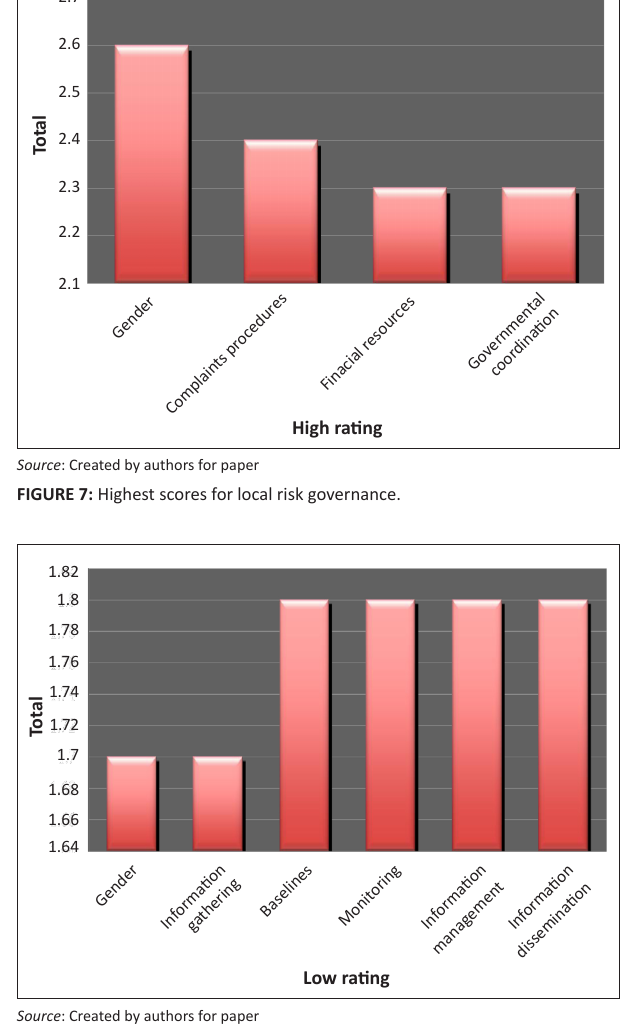
FIGURE 8: Lowest scores for local risk